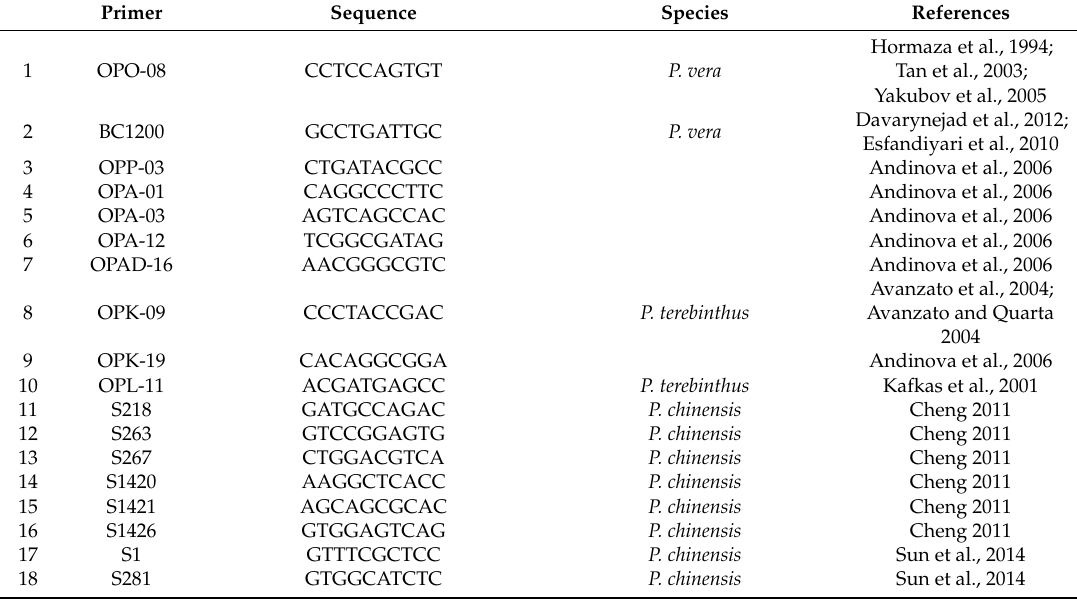
Table 1. Sequences tested for use in sex determination in Pistacia